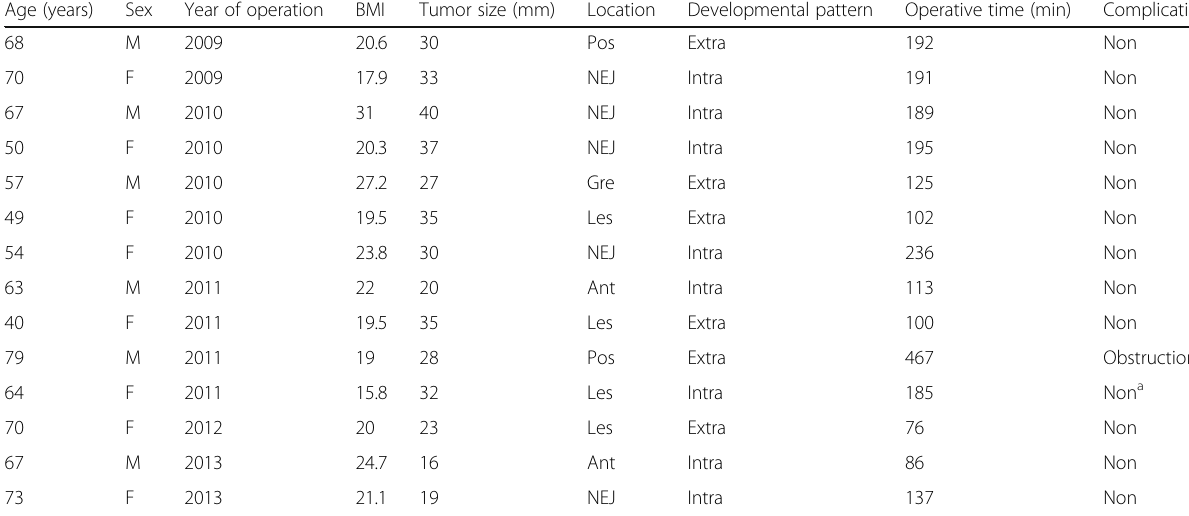
Table 1 Characteristics and surgical outcomes of patients Age